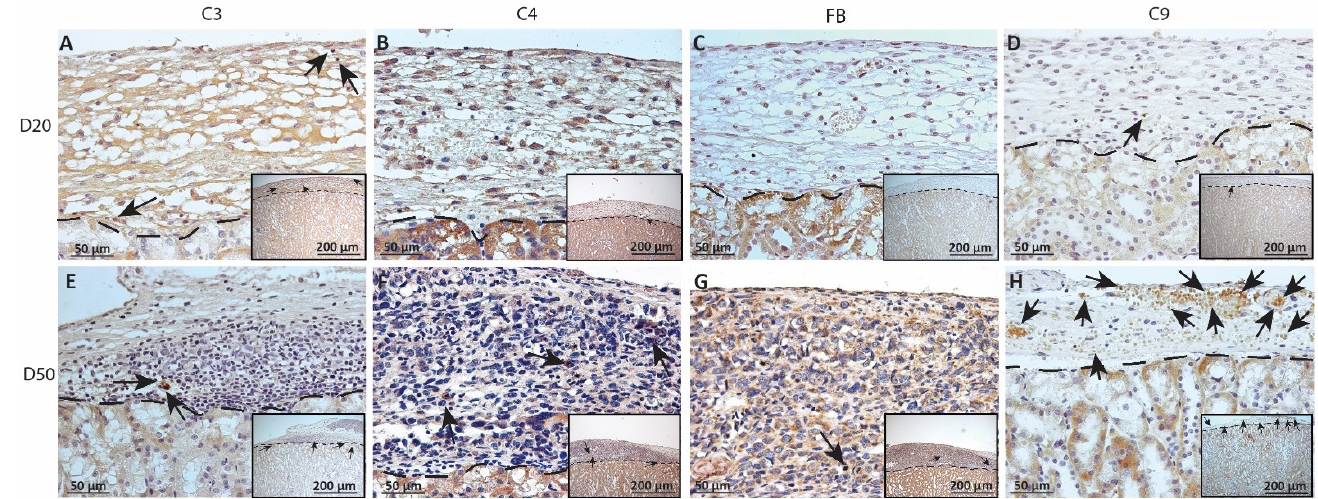
Figure 9. Immunohistochemical analysis of complement fragment deposition on MSC1 chronic timepoint allografts. Graft-bearing MSC1 kidneys were collected at days 20 ( A – D ) and 50 ( E – H ) post-transplantation and tissue sections were immunostained for C3 (brown; A , E ), C4 (brown; B , F ), FB (brown; C , G ), or MAC (brown; D , H ). Insets are lower magnification. A dotted line separates the graft from the kidney. Sections were counterstained with hematoxylin (blue). Arrows indicate examples of positive staining.